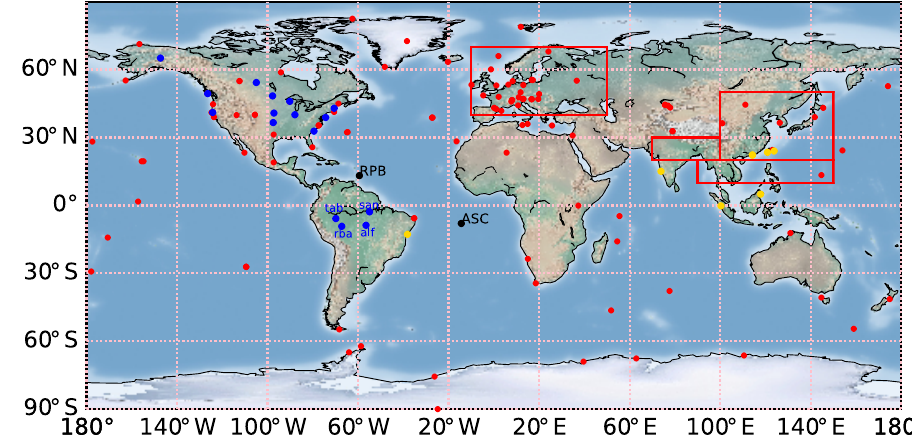
Figure 1. CO 2 sampling locations. Red dots denote the subset of the assimilated site locations that are used here. Yellow dots denote unassimilated site locations. Blue dots denote independent aircraft measurement locations in North and South America (other aircraft sites for the rest of the world are shown in Fig. 2). Specific areas for our study are shown in red: Europe (EUR: 40–70 ◦ N, 10 ◦ W–50 ◦ E), greater northern India (IND: 20–30 ◦ N, 70–100 ◦ E), East Asia (EAS: 20–50 ◦ N, 100–150 ◦ E) and northern Southeast Asia (NSA: 10–20 ◦ N, 90– 160 ◦ E). Stations RPB and ASC, in black even though they have been assimilated, are the NOAA tropical Atlantic sites used to define the